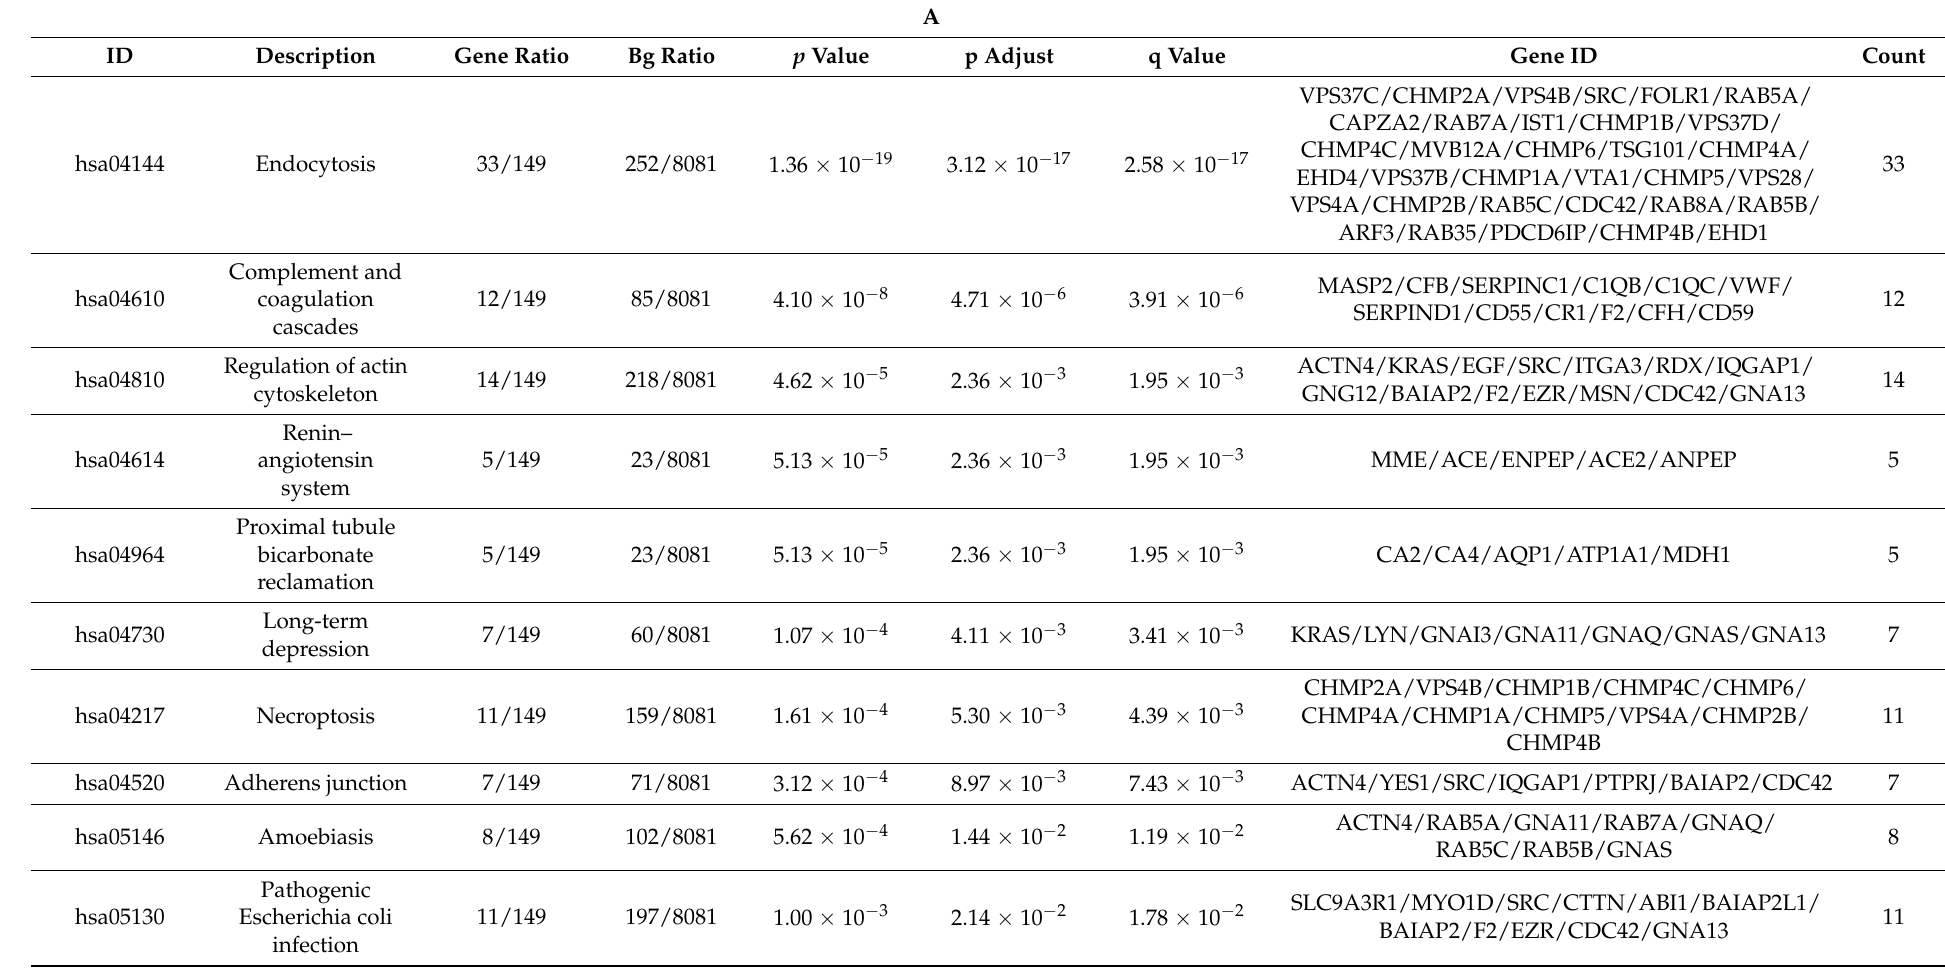
Table 2. Enriched functional signalling networks in the protein sets differing significantly between urine-derived exosomes (A) and tissue-derived exosomes (B).